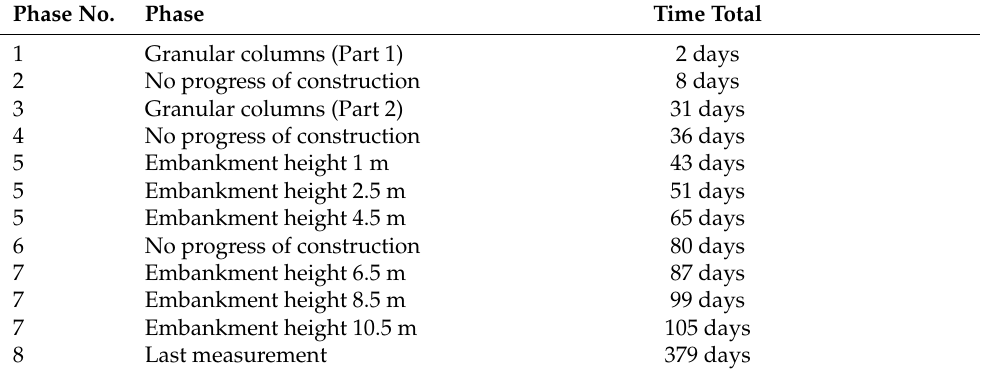
Table 2. Process of construction